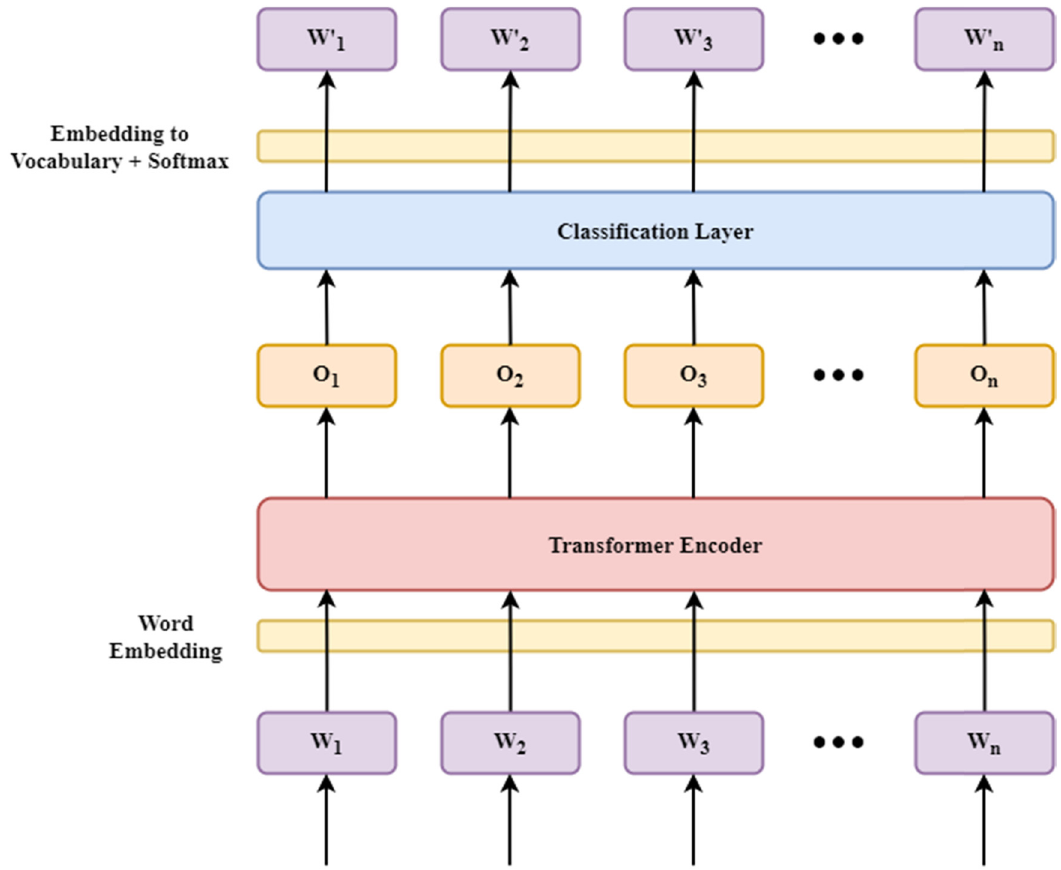
Figure 4: Word embedding